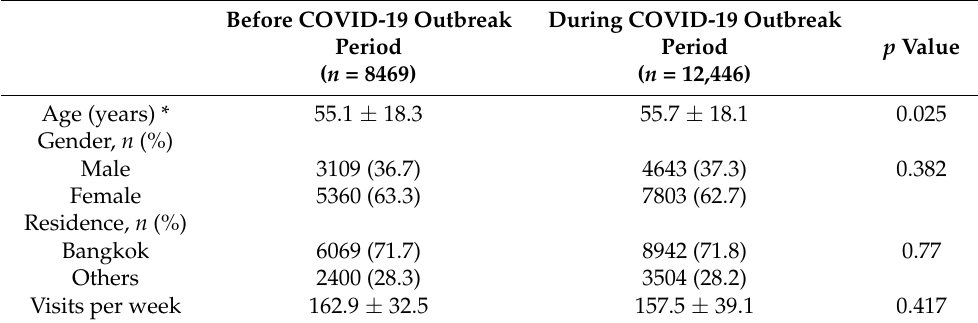
Table 1. A comparison of demographic characteristics of patients visiting outpatient dermatology clinic at Vajira Hospital, Navamindradhiraj University, between the years with and without COVID- 19 outbreak. Before COVID-19 Outbreak During COVID-19 Outbreak p Value Period Period ( n = 8469) ( n = 12,446) 55.1 ± 18.3 55.7 ± 18.1